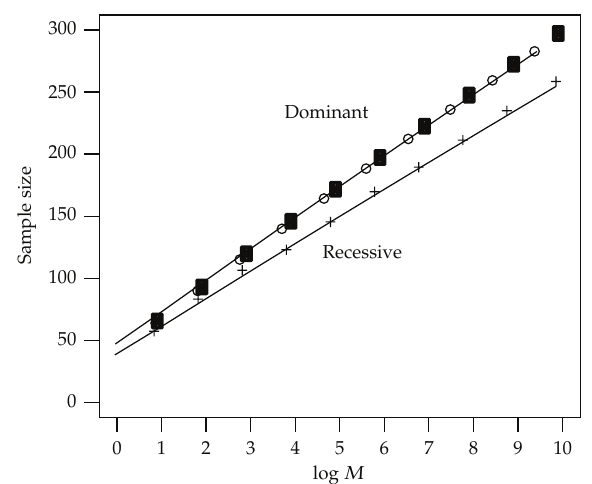
Figure 2: Sample sizes to detect the association at rs1329428 versus numbers of SNPS in genome wide screen of the AMD